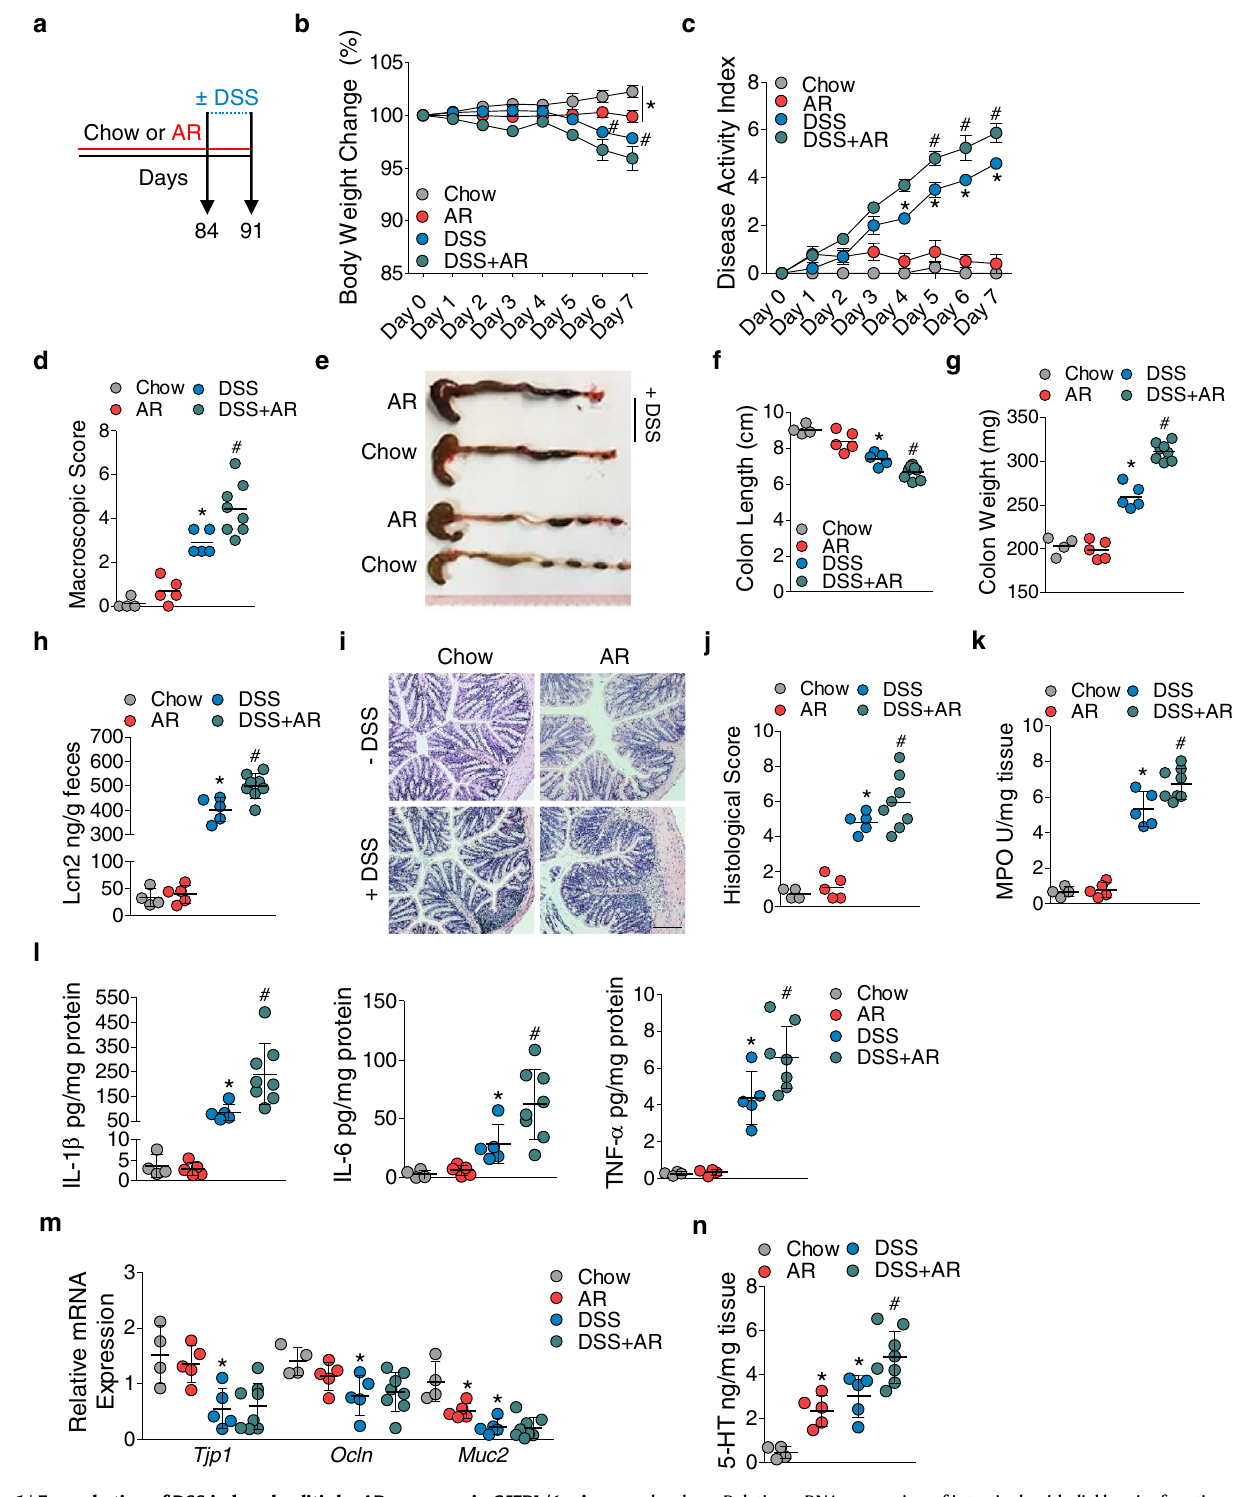
levels. m RelativemRNA expression ofintestinalepithelialbarrier function related genes. n Colonic 5-HT level. b , c Data were analyzed by two-way ANOVA with post hocBonferroni ’ stestandareexpressedasmean±SEM( n =4forChow; n =5forAR andDSS; n =8forDSS+AR). d – n Datawereanalyzedbyone-wayANOVAwithpost hoc Bonferroni ’ s test and are expressed as mean or mean±SD ( n =4 for Chow; n =5 for AR and DSS; n =8 for DSS+AR). Signi fi cance is denoted by * p <0.05, # p <0.05, where * p <0.05 versus Chow, and # p <0.05 versus DSS. Source data are provided as a Source Data